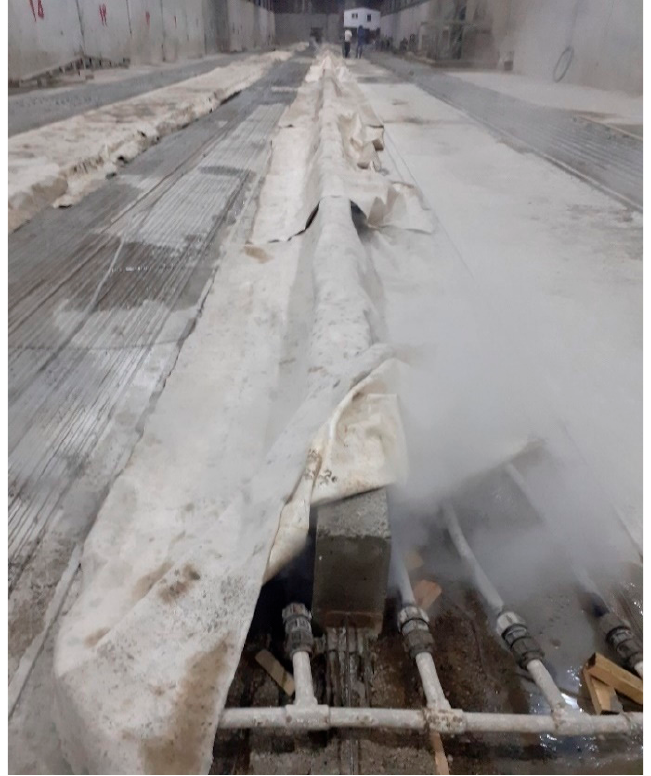
Figure 3. Curing of specimens via the steam method.